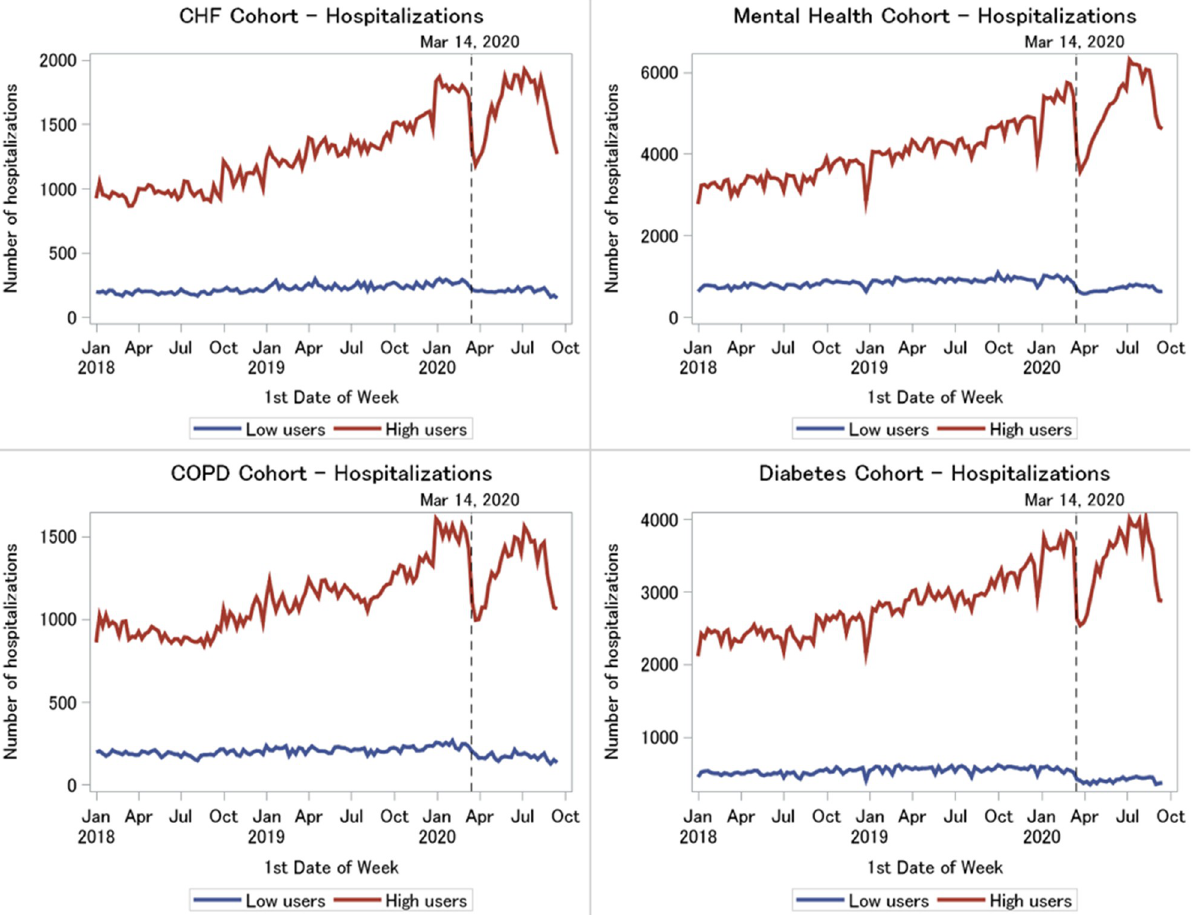
Fig 3. Weekly hospitalizations in high versus low virtual care users by medical condition, January 2018 to September 2020.